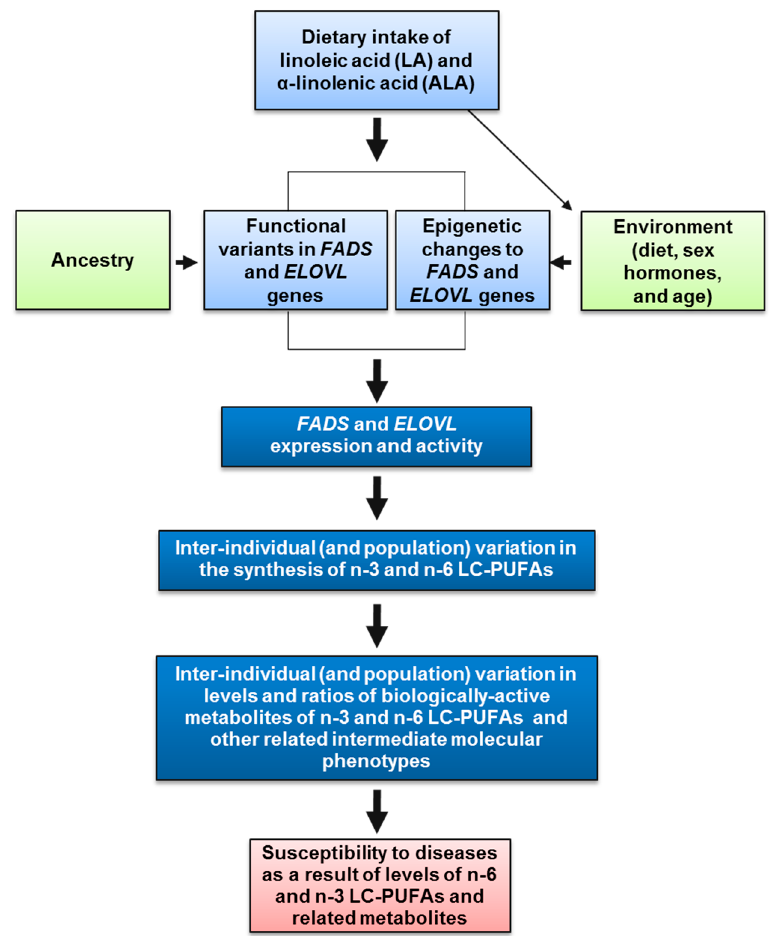
Figure 3. Anatomy of gene-diet interactions leading to n -6 LC-PUFA excesses and n -3 LC-PUFA deficiencies. Dietary intake of n -3 and n -6 18C-PUFAs, ALA and LA, respectively, interact with FADS or ELOVL genetic and epigenetic variation (that impacts FADS or ELOVL expression or resultant activity) to determine circulating and cellular levels of n -3 and n -6 LC-PUFAs. These interactions can result in an unhealthy balance of LC-PUFAs, with excess levels of n -6 LC-PUFAs or deficiencies of n -3 LC-PUFAs.